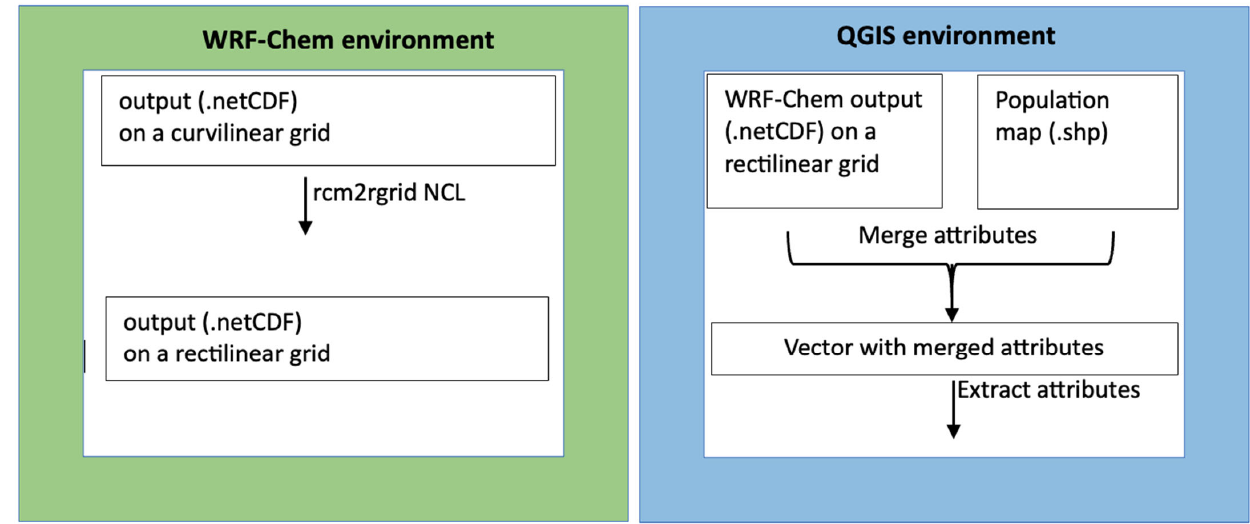
Figure 1. Summary scheme for the merging of WRF-Chem output and population map file in QGIS environment.